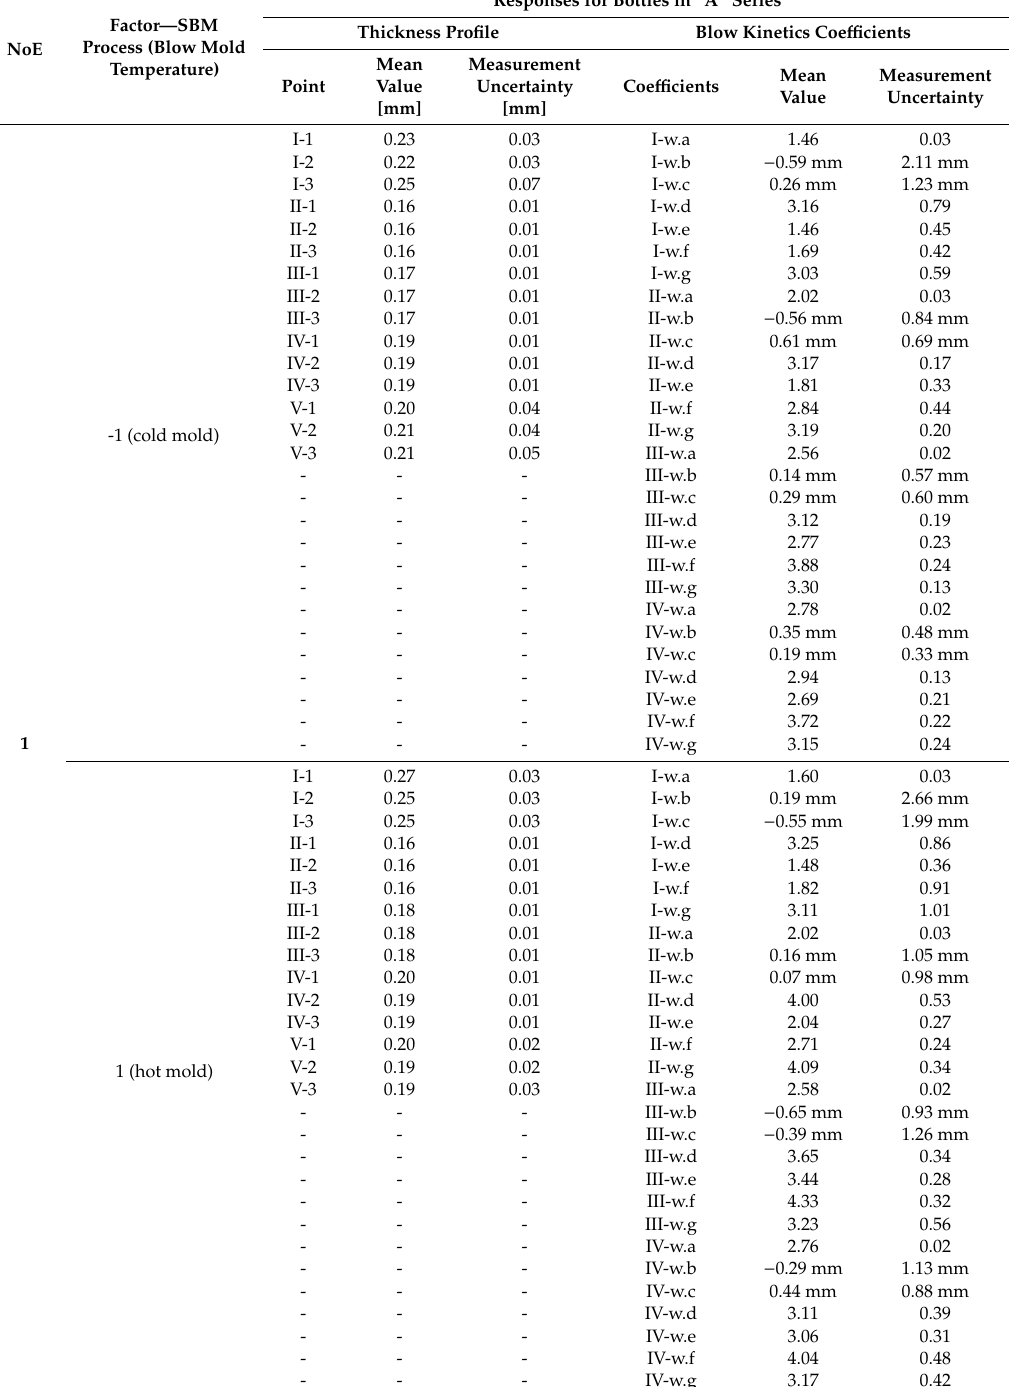
Table 5. Plan for one one-factor, bivalent experiment for testing thickness profile, and blow kinetics coe ffi cients (NoE—Number of